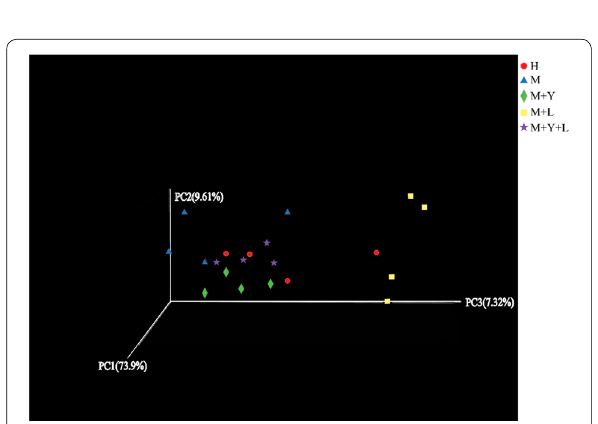
Fig. 3 Scatterplots from principal coordinates analysis (PCoA), based on weighted UniFrac distance in bacterial